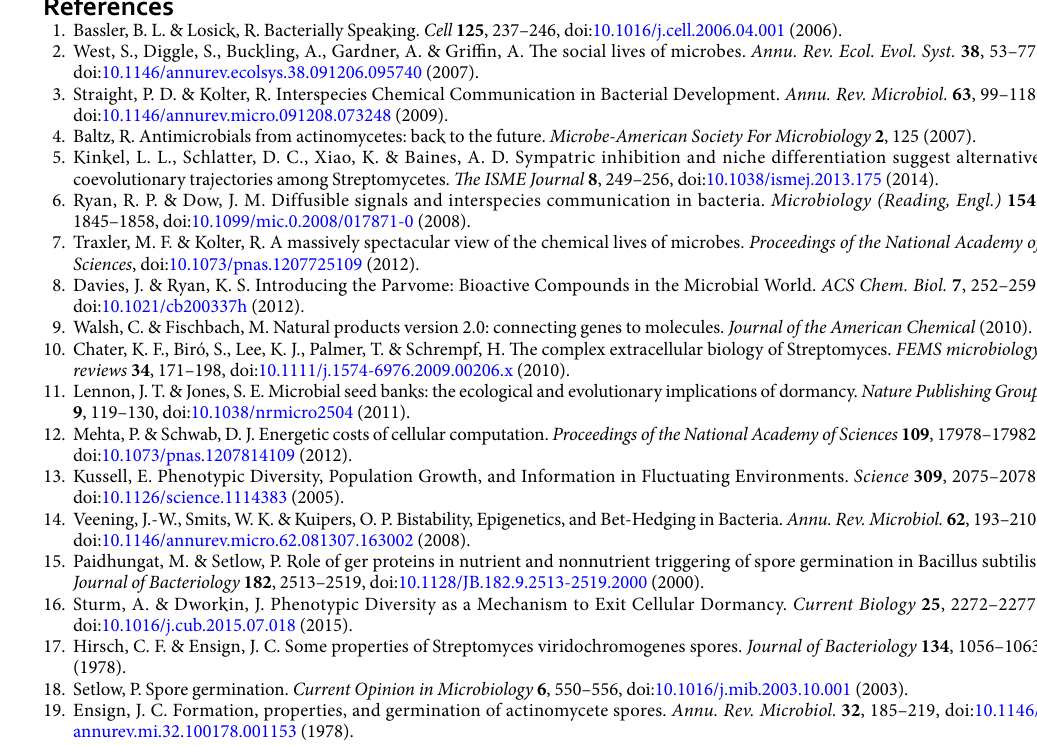
Figure 5: These are the same data as in Fig. 4 but analyzed for mycelium growth. Mycelium sample sizes (a) n buffer = 17, n germsup = 87; (b) n buffer = 81, n germsup = 122; (c) n buffer = 258, n germsup = 87. Influence of germsup on ini- tial growth rate of treated spores (column II): ISP5230 germsup promote growth rate of its old spores, p = 0.0091; ISP5230 germsup did not affect growth rate of M145, p = 0.0681; B1511 germsup promote growth rate of M145, p = 3 × 10 − 6 . Influence of germsup on stalling fraction of treated spores (column III): ISP5230 germsup on its old spores, NA ; ISP5230 germsup had no effect on stalling fraction of M145, p = 0.8695; B1511 germsup reduced stalling fraction of M145, p = 0.037. Figure 6(b) Spores in mono or mix culture were randomly scored from 40 fields of views of two wells and repeated once in an independent experiment. Only interactions significant in all independent experiments were highlighted and claimed in the result. Sample sizes: ISP5230 vs. M145, n mix_red = 303, n mix_green = 638, n mono_ = 336, n = 503. ISP5230 vs. GrRd7, n = 285, n = 388, n = 332, n = 316. red mono_green mix_red mix_green mono_red mono_green ISP5230 vs. B1511, n mix_red = 258, n mix_green = 324, n mono_red = 295, n mono_green = 261. B1511 vs. GrRd7, n mix_red = 488, n mix_green = 478, n mono_red = 466, n mono_green = 395. B1511 vs. M145, n mix_red = 504, n mix_green = 520, n mono_red = 508, n mono_green = 529. M145 vs. GrRd7, n mix_red = 496, n mix_green = 487, n mono_red = 509, n mono_green = 301. p values for highlighted significant interactions: ISP5230 was inhibited by co-cultured M145, p < 10 − 26 ; M145 was inhibited by co-cultured B1511, p < 10 − 15